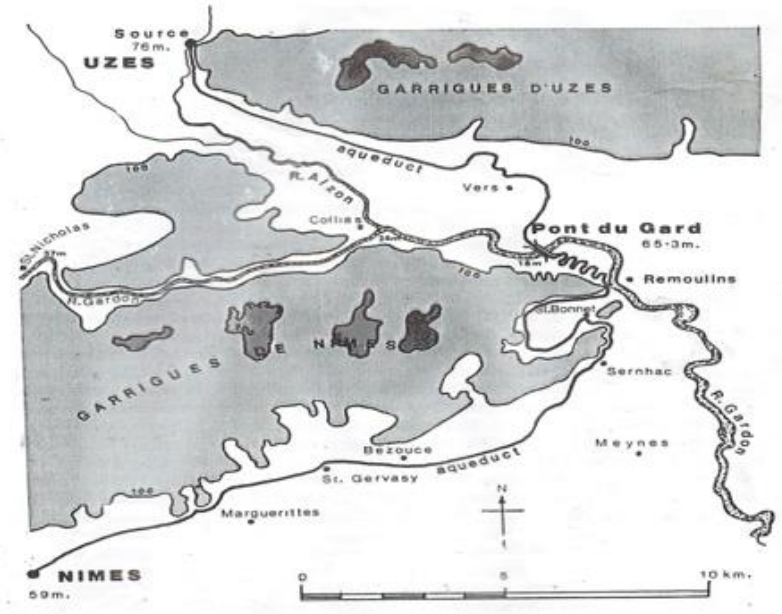
Figure 37. The aqueduct path from the spring source at Uzes to the water distribution castellum, Figure 36, within the city of Nîmes, France (Roman Nemausus). Figure derived from [30].